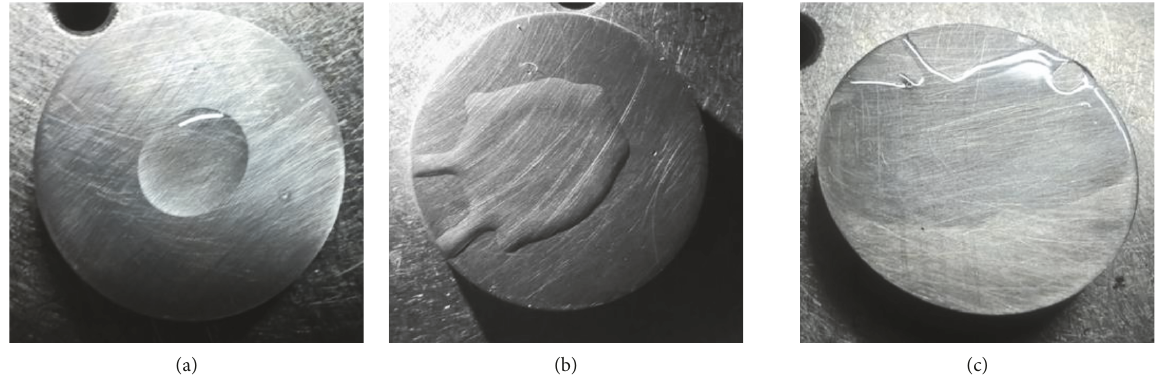
Figure 5: Photos of 20 μ L oil droplet on (a) steady support; after rotating at 18 rpm (b) and 45rpm (c).